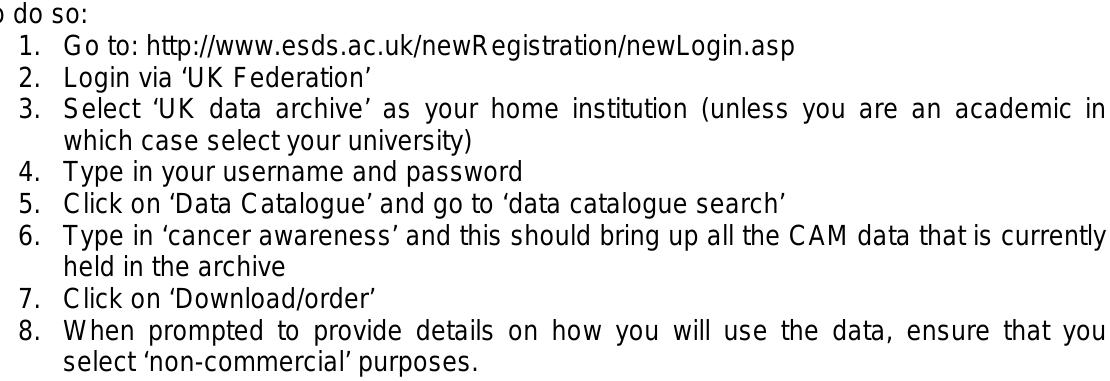
Cervical Cancer Awareness Measure Toolkit Version 2.1 Updated